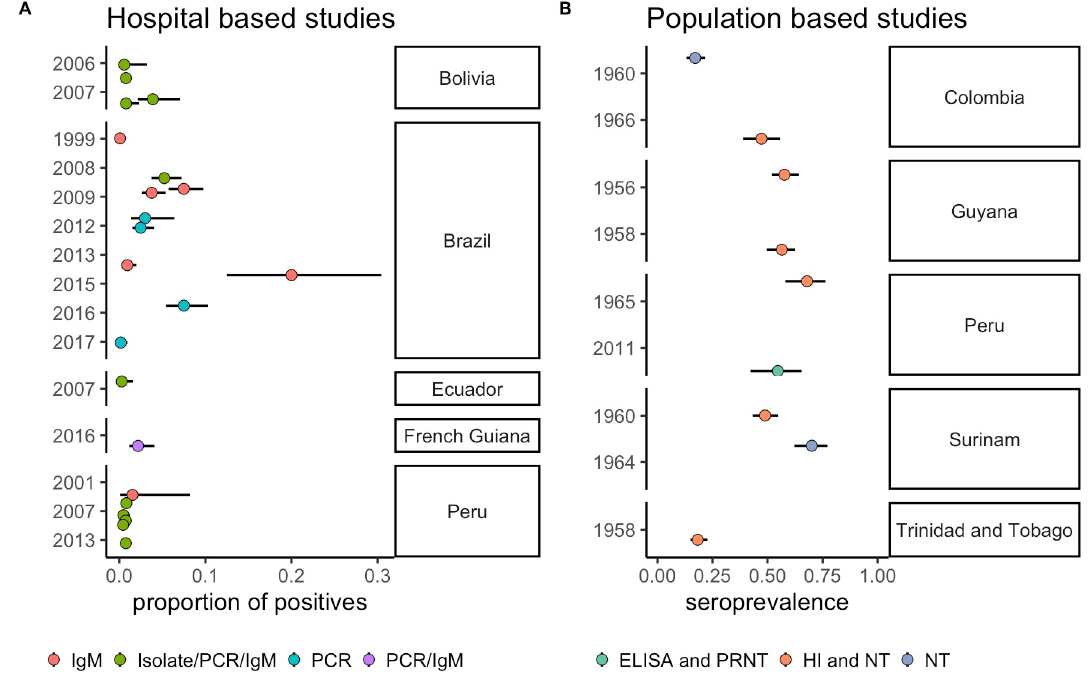
Fig 3. Hospital-based surveillance and cross-sectional seroprevalence studies of MAYV. Points indicate the mean and lines represent the 95% confidence interval. Colours indicate the type of test used to confirm cases.